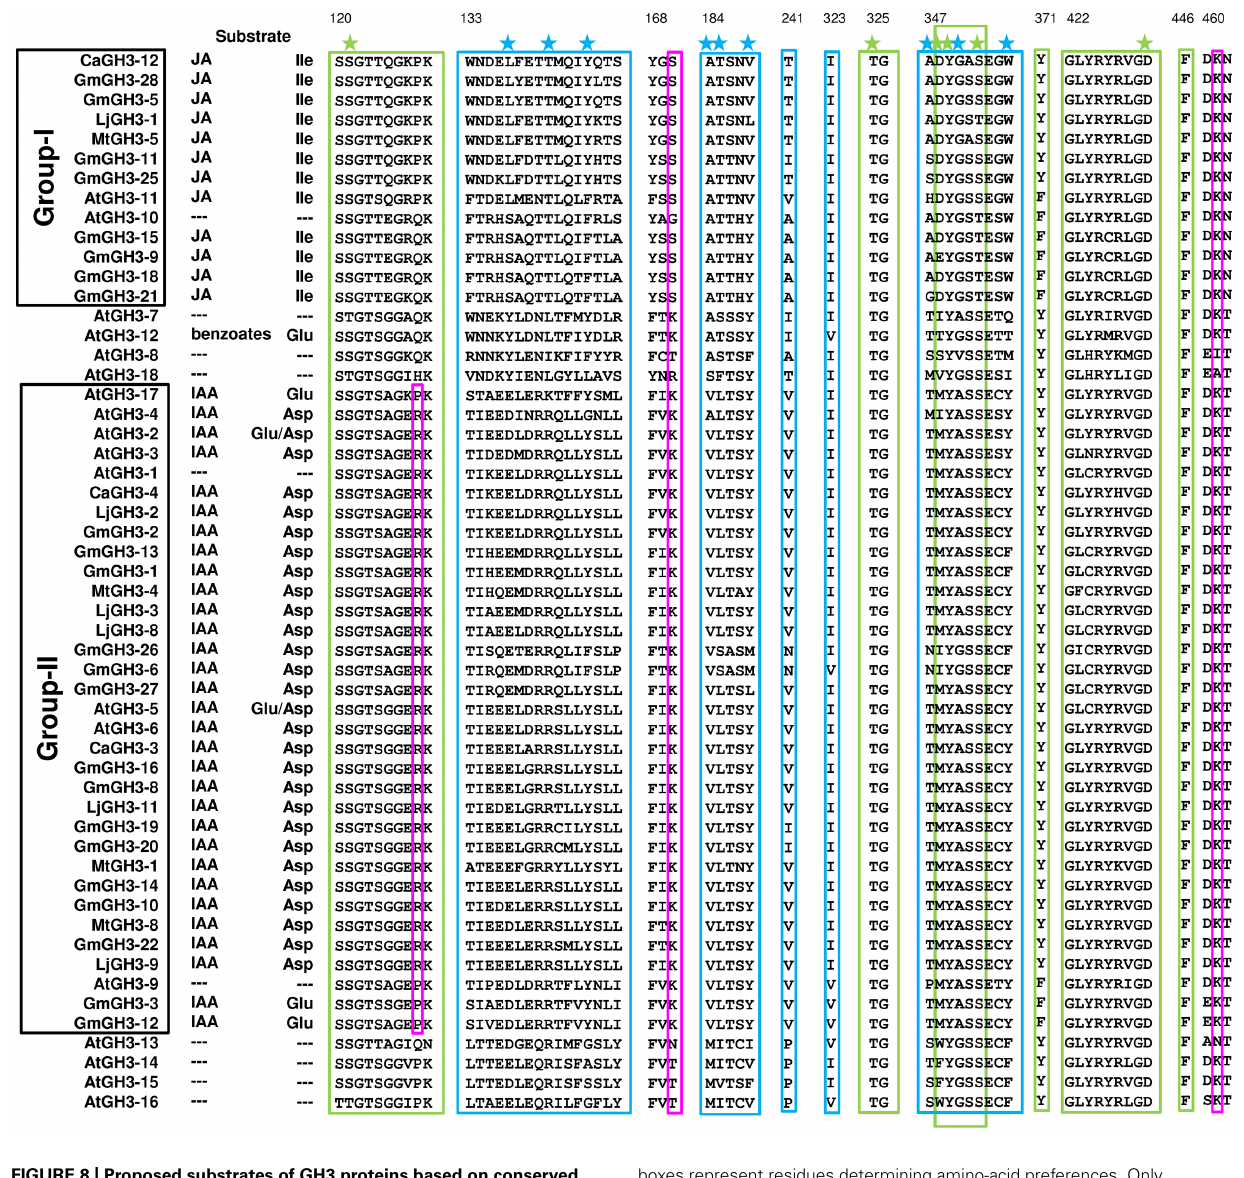
FIGURE 8 | Proposed substrates of GH3 proteins based on conserved amino acid residues. Protein sequences of all the identified GH3 genes were aligned using MAFFT. Green and blue boxes represent nucleotide (ATP/AMP) and hormone-binding motifs/residues, respectively. Magenta